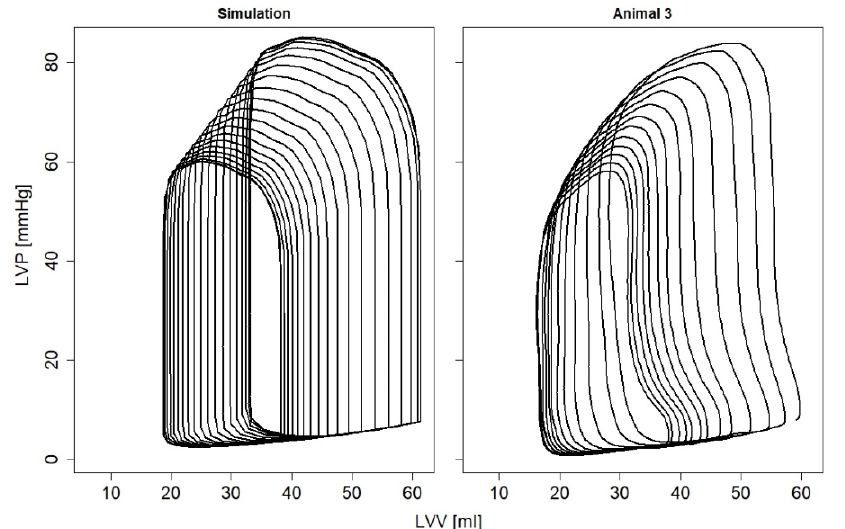
Figure 4. Pressure and volume data of a virtual and in-vivo preload reduction of the simulated and real animal 3. LVP: left ventricular pressure; LVV: left ventricular volume.